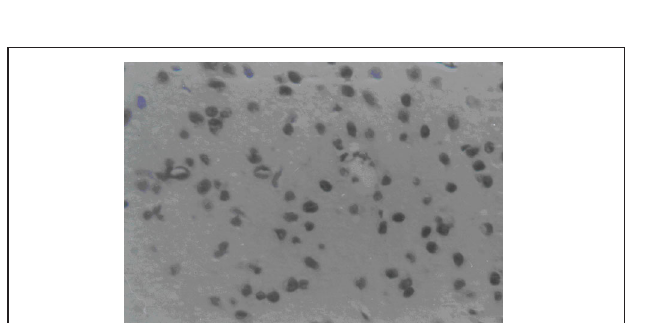
FIGURE 7 | Immunohistochemical findings of GDNF + MSCs group at 14 days after